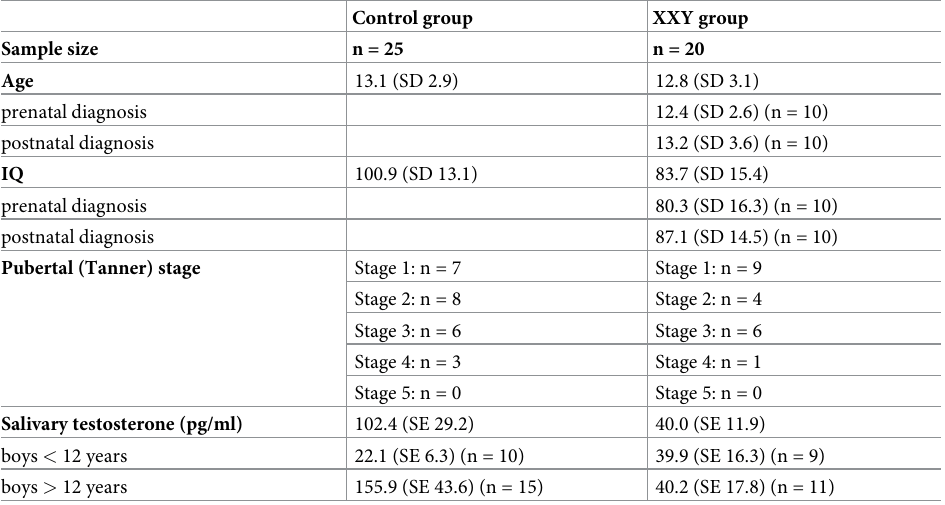
Table 1. Characteristics of the control group and XXY